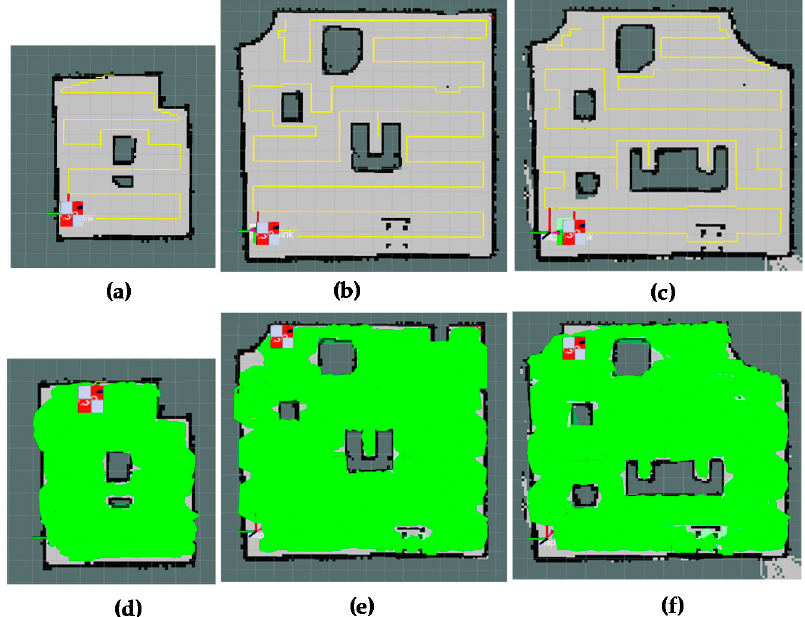
Figure 20. Morphology reconfigurations from O shape to vertical I shape to navigate through the narrow spaces constraints on real environment. ( a ) Detected narrow spaces as red arrows, ( b ) the position before reconfiguring morphology, ( c ) starting morphology reconfiguration, ( d ) navigating with vertical I shape, ( e ) Morphology reshapes to O after going out of narrow space, ( f ) keep navigating with O shape.